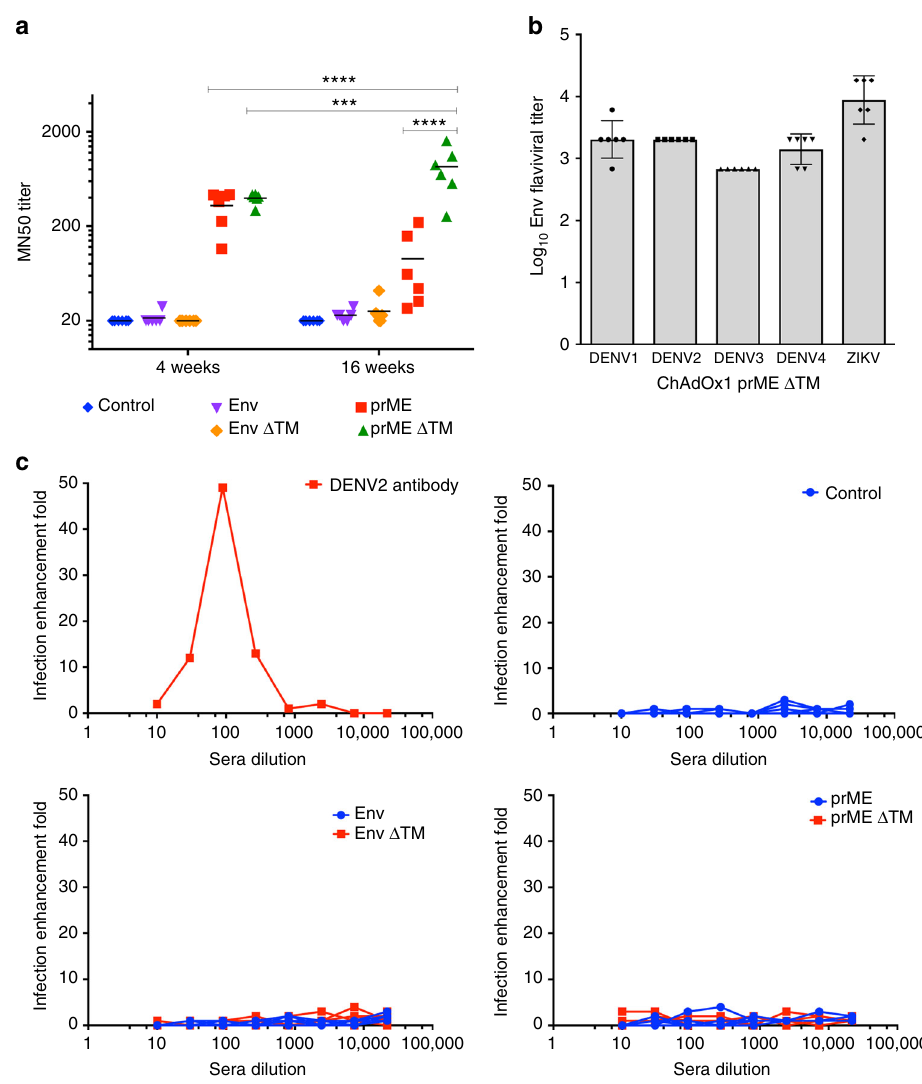
Fig. 4 ZIKV neutralisation assay and antibody-dependent enhancement (ADE) to DENV2 infection. a Microneutralisation titre 50 (MN50) assay in Vero cells was assessed upon incubation of ZIKV-BR in the presence of serially diluted sera from BALB/c mice vaccinated with ChAdOx1 ZIKV vaccines at 4 weeks and 4 months. Results show the average of three biological replicates, with duplicates and black lines represents the mean ( n = 6). A two-way ANOVA followed by Sidak ’ s Multiple comparison was performed. **** p < 0.0001, *** p < 0.0003. Supplementary Table 1 shows the multiple comparison between all the groups. b ELISA cross-reactivity of DENV1-4 in sera from mice vaccinated with the highly protective ChAdOx1 prME Δ TM vaccine. Bars represent the average and error is the s.d. c Infection of U937 cells by a DENV2 strain in the presence of sera from mice vaccinated with ChAdOx1 ZIKV candidates. Infection enhancement fold was calculated as the ratio of focus-forming units (FFU) of an anti-DENV2 monoclonal antibody to that of the FFU in the presence of serial dilutions of mouse sera collected 4 weeks after ChAdOx1 ZIKV vaccination. Each coloured line and shape represents a mouse for each group. n = 6/vaccinated group. Data represent three technical replicates, with a positive control anti-DENV2